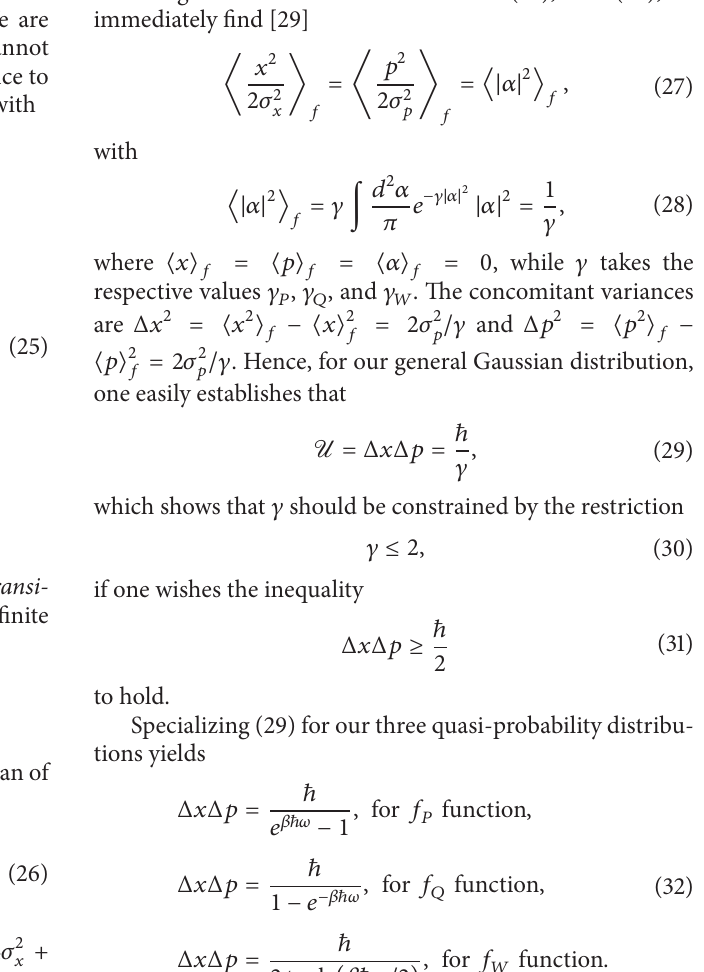
= 𝑇 𝑘 /ℏ𝜔 = ln 3 𝐵 crit crit